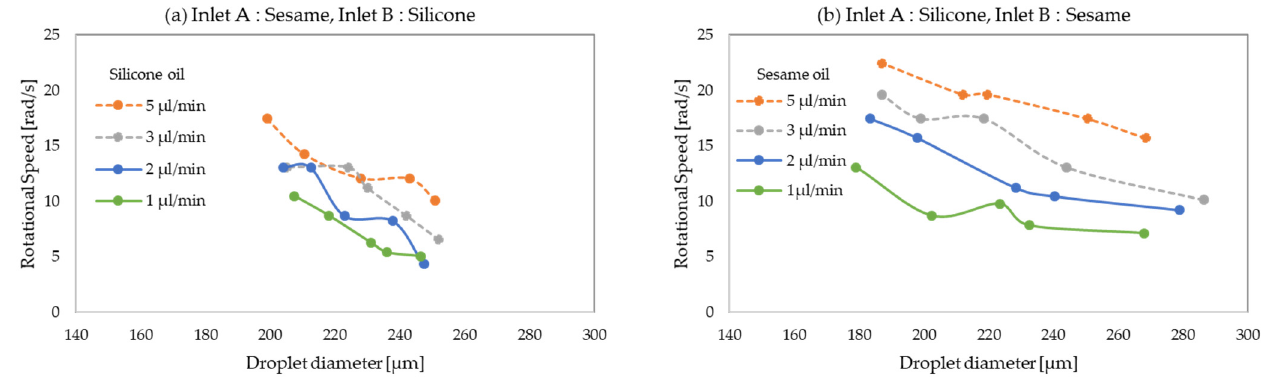
Figure 7. Rotational speed of droplet versus droplet diameter. ( a ) Clockwise rotation; ( b ) anti-clockwise rotation.